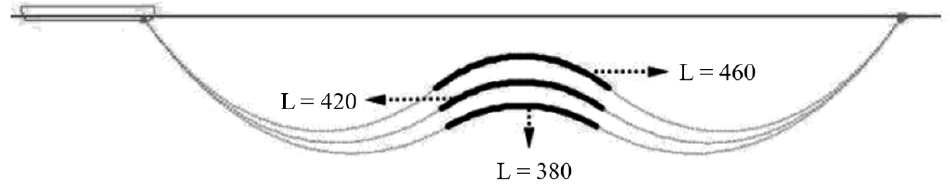
Figure 15. Shapes of OOL with different coverage length of buoyancy material.